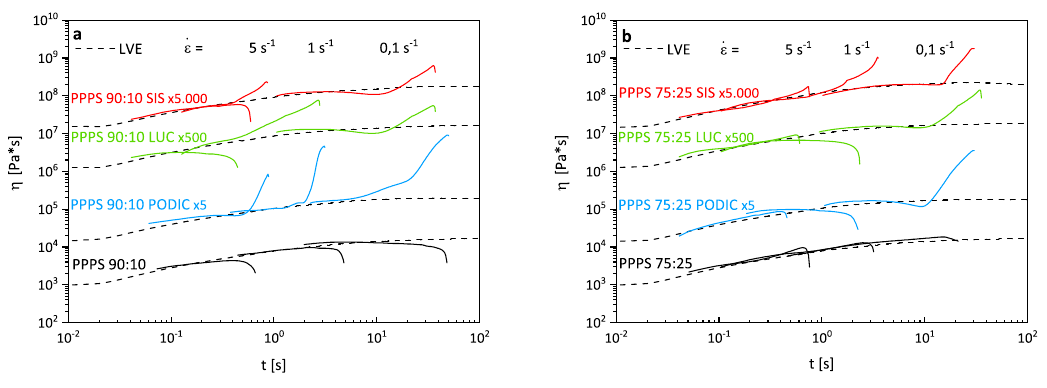
Figure 7. Extensional rheology curves of PP–PS 90:10 ( a ) and PP–PS 75:25 ( b ) blends; measured at 180 ◦